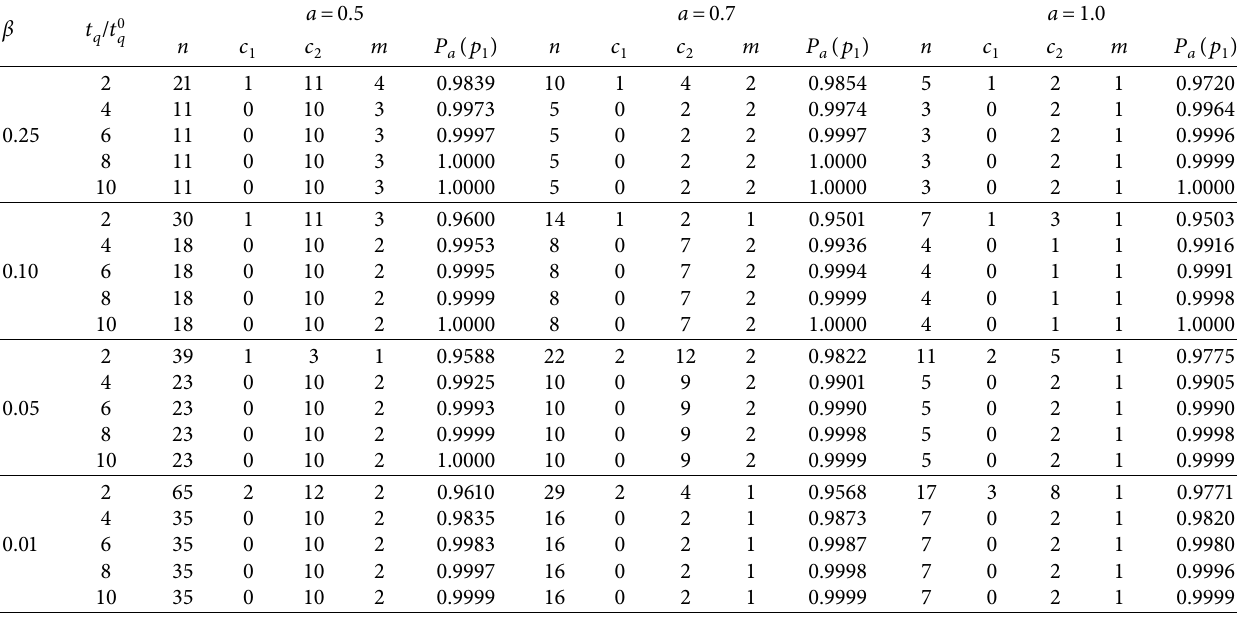
Table 2: Optimal parameters of the proposed MDSSP for EWD with δ � 2 , c � 1 . 5 at 50 th